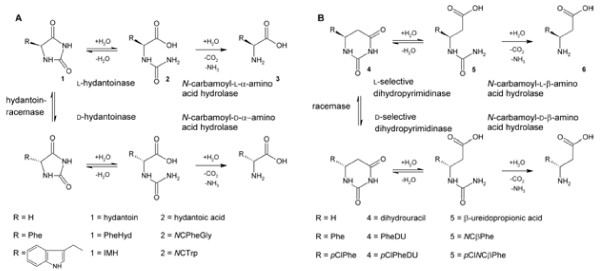
A) Hydantoinase process for the synthesis of chiral D- or L-α-amino acids starting from racemic 5’-monosubstituted hydantoins via N-carbamoyl-α-amino acids applying a hydantoin racemase, a specific hydantoinase and a specific N-carbamoyl-α-amino acid hydrolase; B) proposed modified hydantoinase process for the synthesis of chiral D- or L-β-amino acids starting from racemic 6’-monosubstituted dihydropyrimidines via N-carbamoyl-β-amino acids applying a racemase, a dihydropyrimidinase and a N-carbamoyl-β-amino acid hydrolase; (1) 5’-monosubstituted hydantoin, (2) N-carbamoyl-α-amino acid, (3) α-amino acid, (4) 6’-monosubstituted dihydropyrimidine, (5) N-carbamoyl-β-amino acid, (6) β-amino acid; PheHyd: phenylhydantoin, NCPheGly: N-carbamoyl-α-phenylglycine, PheDU: phenyldihydrouracil, NCβPhe: N-carbamoyl-β-phenylalanine, IMH: indolymethyl hydantoin, NCTrp: N-carbamoyl-α-tryptophan, pClPheDU: para-chloro-phenyldihydrouracil, pClNCβPhe: para-chloro-N-carbamoyl-β-phenylalanine.